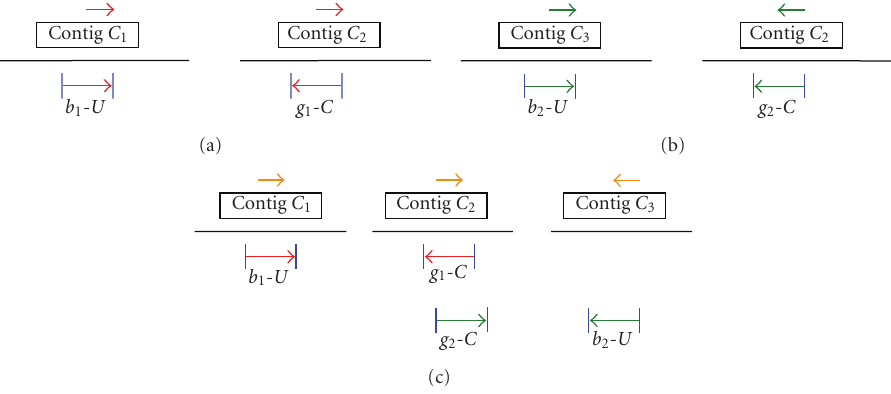
Figure 2: Determining the relative orientations of contigs using mate-pair information. (a): b 1 and g 1 reads determine the relative orientation of contigs C 1 and C 2 ; (b): b 2 and g 2 reads determine the relative orientations of contigs C 2 and C 3 ; and (c): the relative orientations of contigs C 1 , C 2 , and C 3 are determined by rotating the sca ff old in Figure